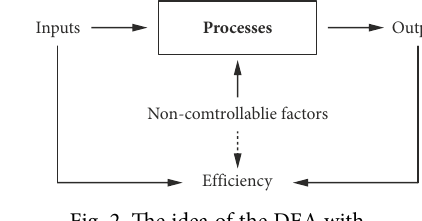
Fig. 1. The idea of the DEA Fig. 2. The idea of the DEA with